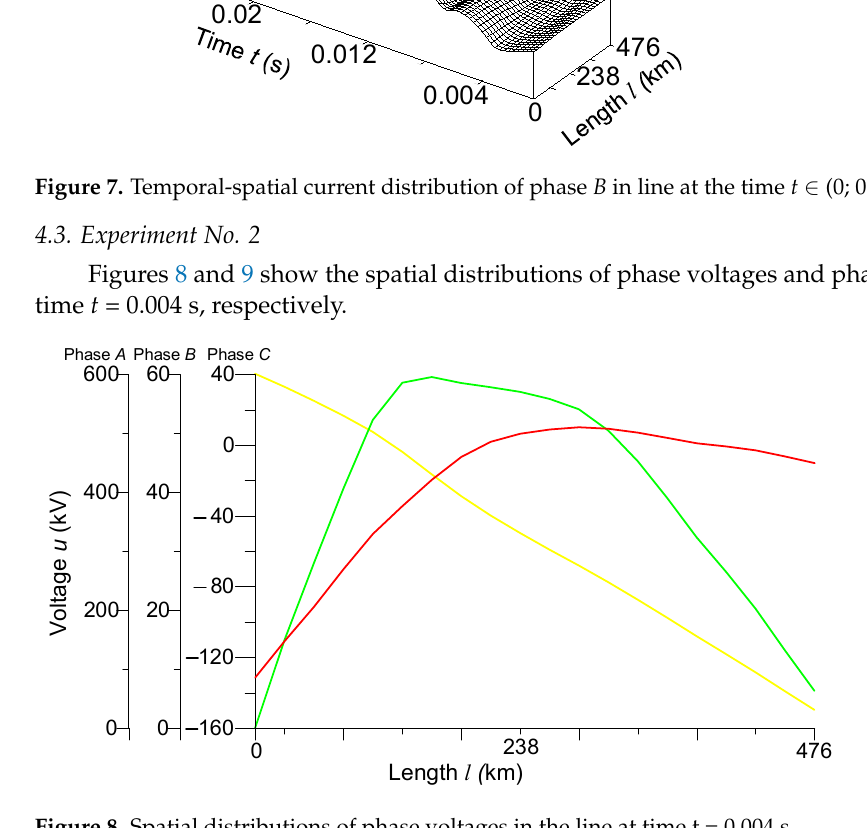
Figure 8. Spatial distributions of phase voltages in the line at time t = 0.004 s.